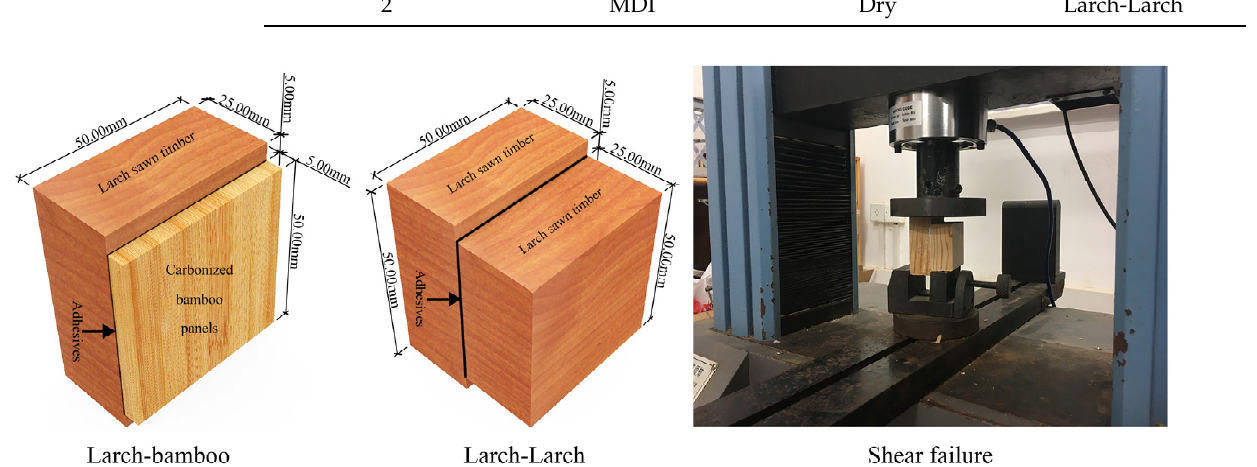
Table 1. Variation and experimental level of specimen.